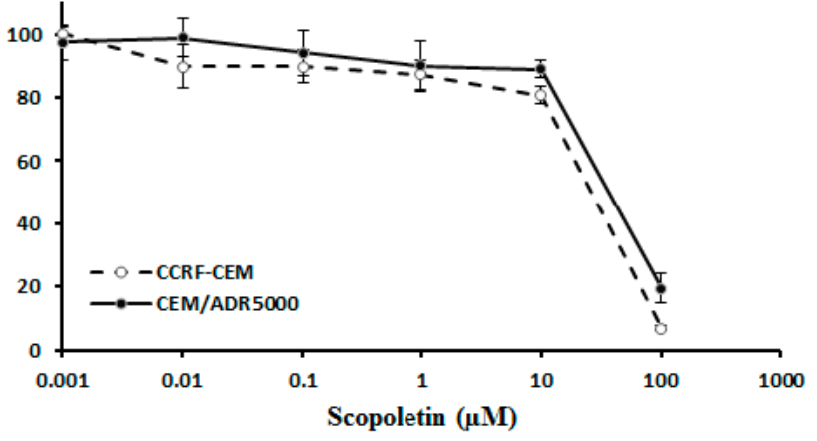
Figure 4. Dose response curves of scopoletin in drug-sensitive CCRF-CEM and P-glycoprotein-expressing multidrug-resistant CEM/ADR5000 cells as determined by the resazurin assay. The dose response curves show mean values ± SD of three independent experiments with each six parallel measurements.